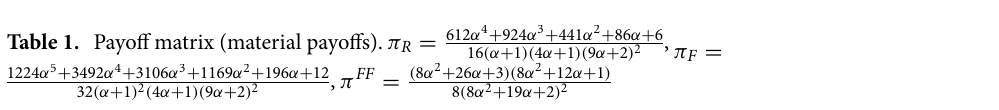
Table 1. Payoff matrix (material payoffs). π R =